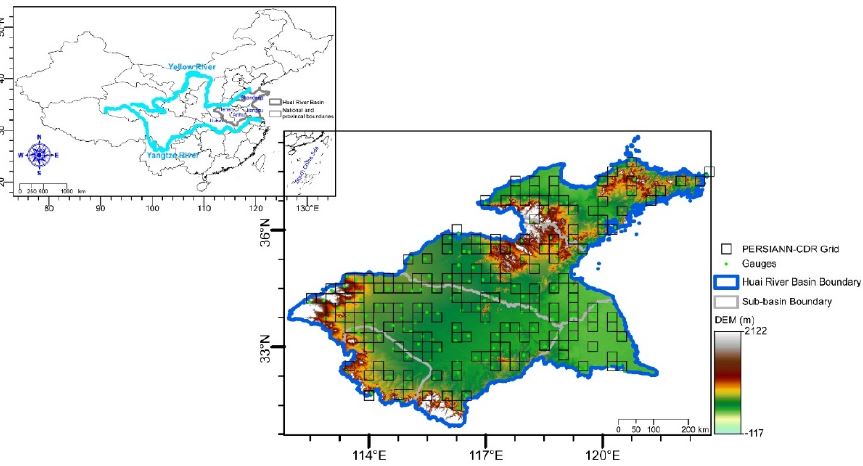
Figure 1. Location of the HRB with gauges and PERSIANN-CDR grids. The digital elevation model (DEM) with a spatial resolution of 90 m is from http://srtm.csi.cgiar.org/ (accessed on 1 January 2021).